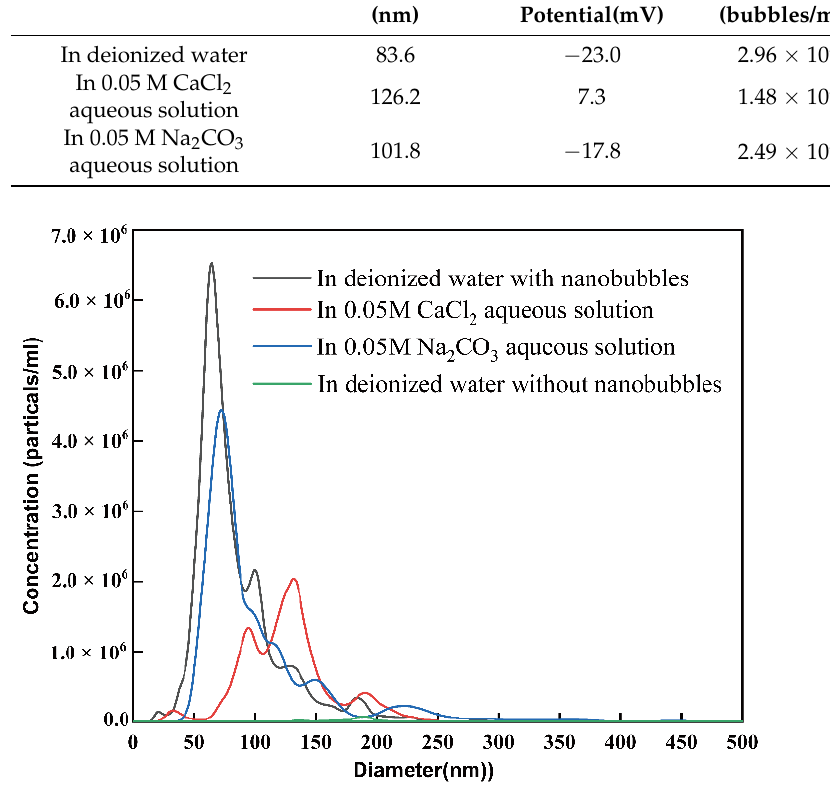
Figure 2. Size distribution of nanobubbles in deionized water with nanobubbles, in 0.05 M CaCl 2 aqueous solution, 0.05 M Na 2 CO 3 aqueous solution or in deionized water without nanobubbles.